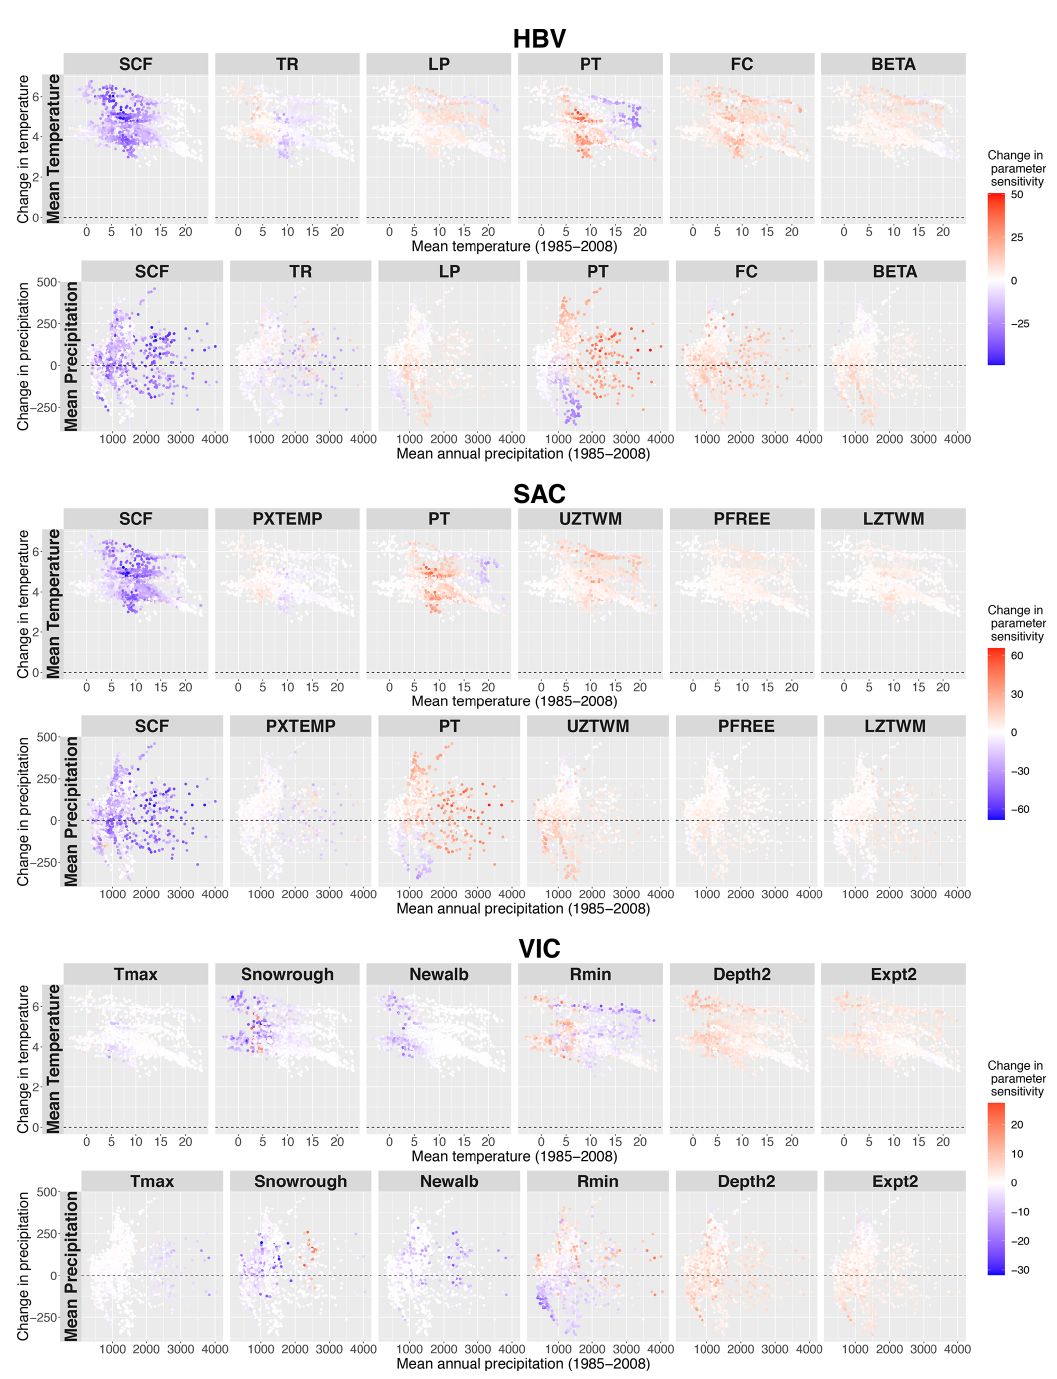
Figure B1. Change vs. historical values in mean temperature and mean precipitation over 605 basins, with change in parameter sensitivity indicated using mean discharge as the target variable. All three climate scenarios are shown together in each subplot. Parameter sensitivity for the historical period is expressed as dot size. Change in parameter sensitivity in colour. Red colours indicate an increase in sensitivity, blue a